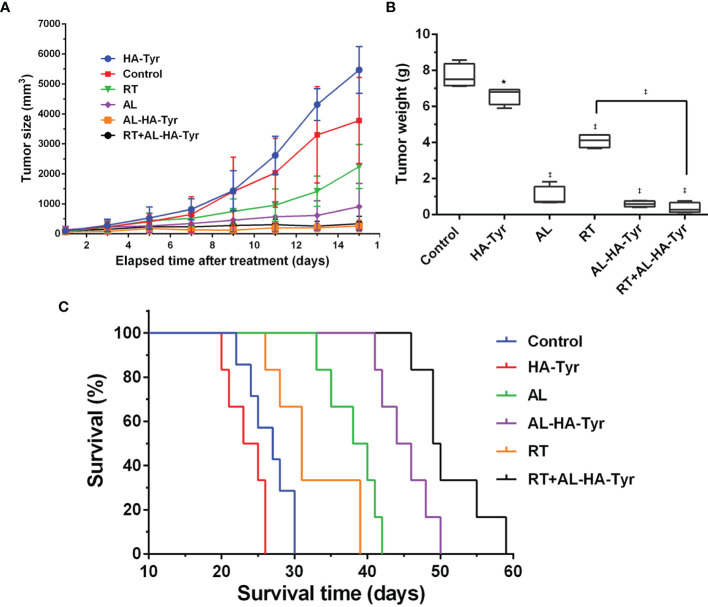
Tumor growth was inhibited, and survival was prolonged by radiotherapy (RT) + anlotinib hydrogel (AL-HA-Tyr) in LLC model. (A) Tumor size at indicated times (n = 6). (B) Weight of excised tumors. (n = 4; *P < 0.05, and ‡P < 0.001,Control vs. hyaluronic acid-tyramine (HA-Tyr), anlotinib (AL), AL-HA-Tyr, RT, and RT + AL-HA-Tyr P < 0.01, RT vs. AL-HA-Tyr+ RT. (C) Survival of mice in each group (n = 6).